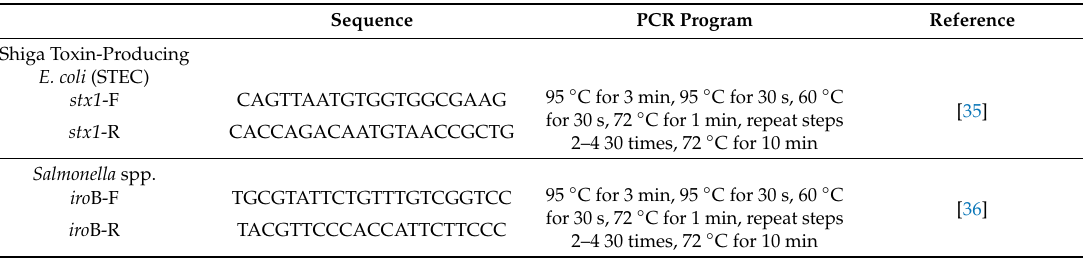
6 × DNA safe stain loading dye (Bullseye DNA Safe Stain C138, MIDSCI, St. Louis, MO, USA) and loaded into a 1% agarose gel (H26855 Agarose D1-LE, Thermo scientific, Co. Ltd., USA) in 50 mL of 1 × TAE bu ff er (Tris-acetate-EDTA, Thermo scientific, Co. Ltd., USA). The gel was run at 110 V for 35 min. using a PowerPac TM Basic Power Supply (Bio-Rad, Hercules, CA, USA). The gel was then imaged using a Gel Doc EZ Imager (Bio-Rad, Hercules, CA, USA). Table 1. PCR primers and program for STEC and Salmonella spp. Sequence